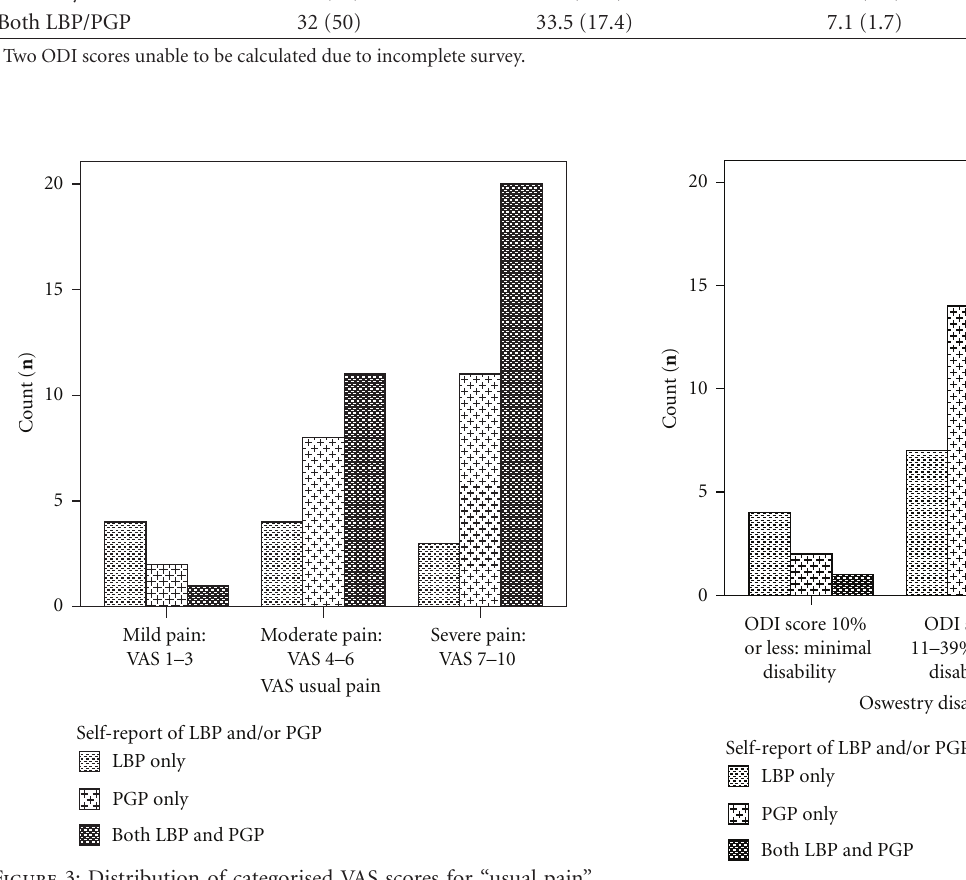
Figure 3: Distribution of categorised VAS scores for “usual pain” across the 3 categories: LBP, PGP, and both LBP and PGP.